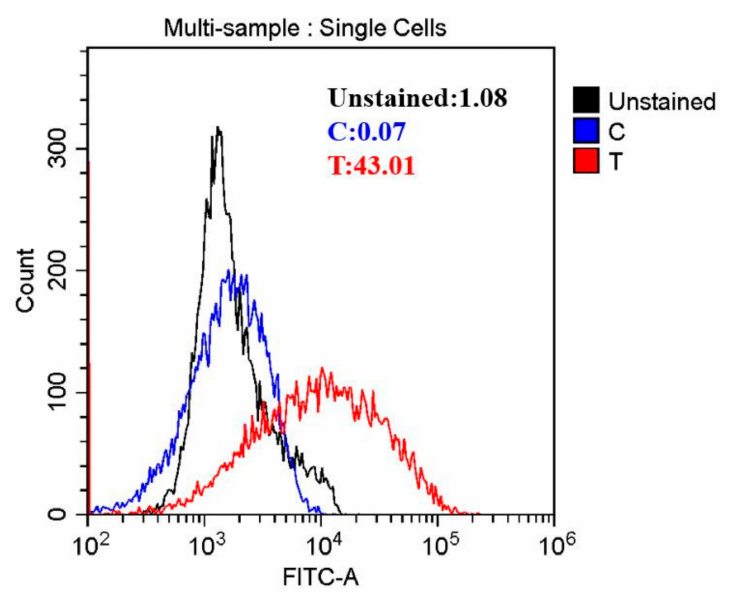
Figure 3. The reactive oxygen species (ROS) of A. johnsonii after HVEF